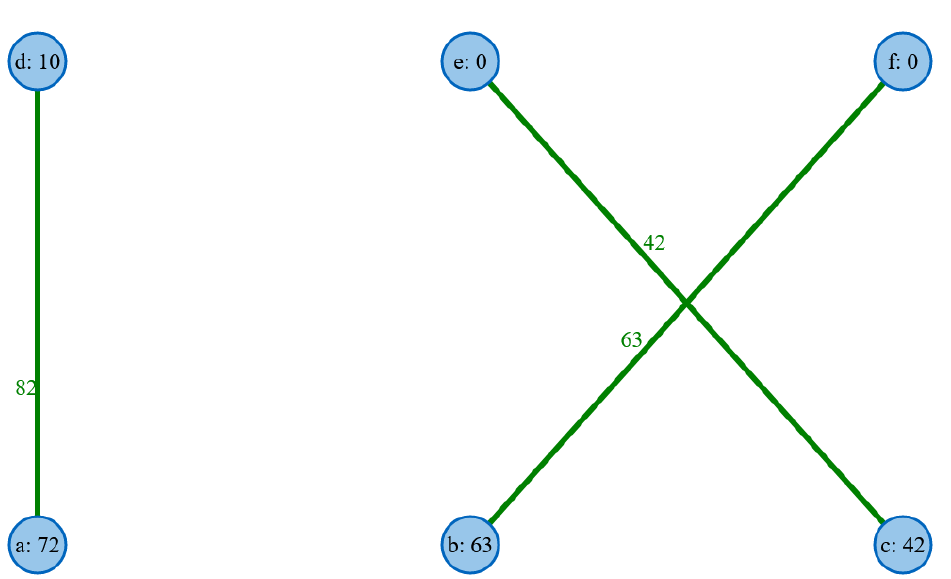
Figure 3. Augmentation way.